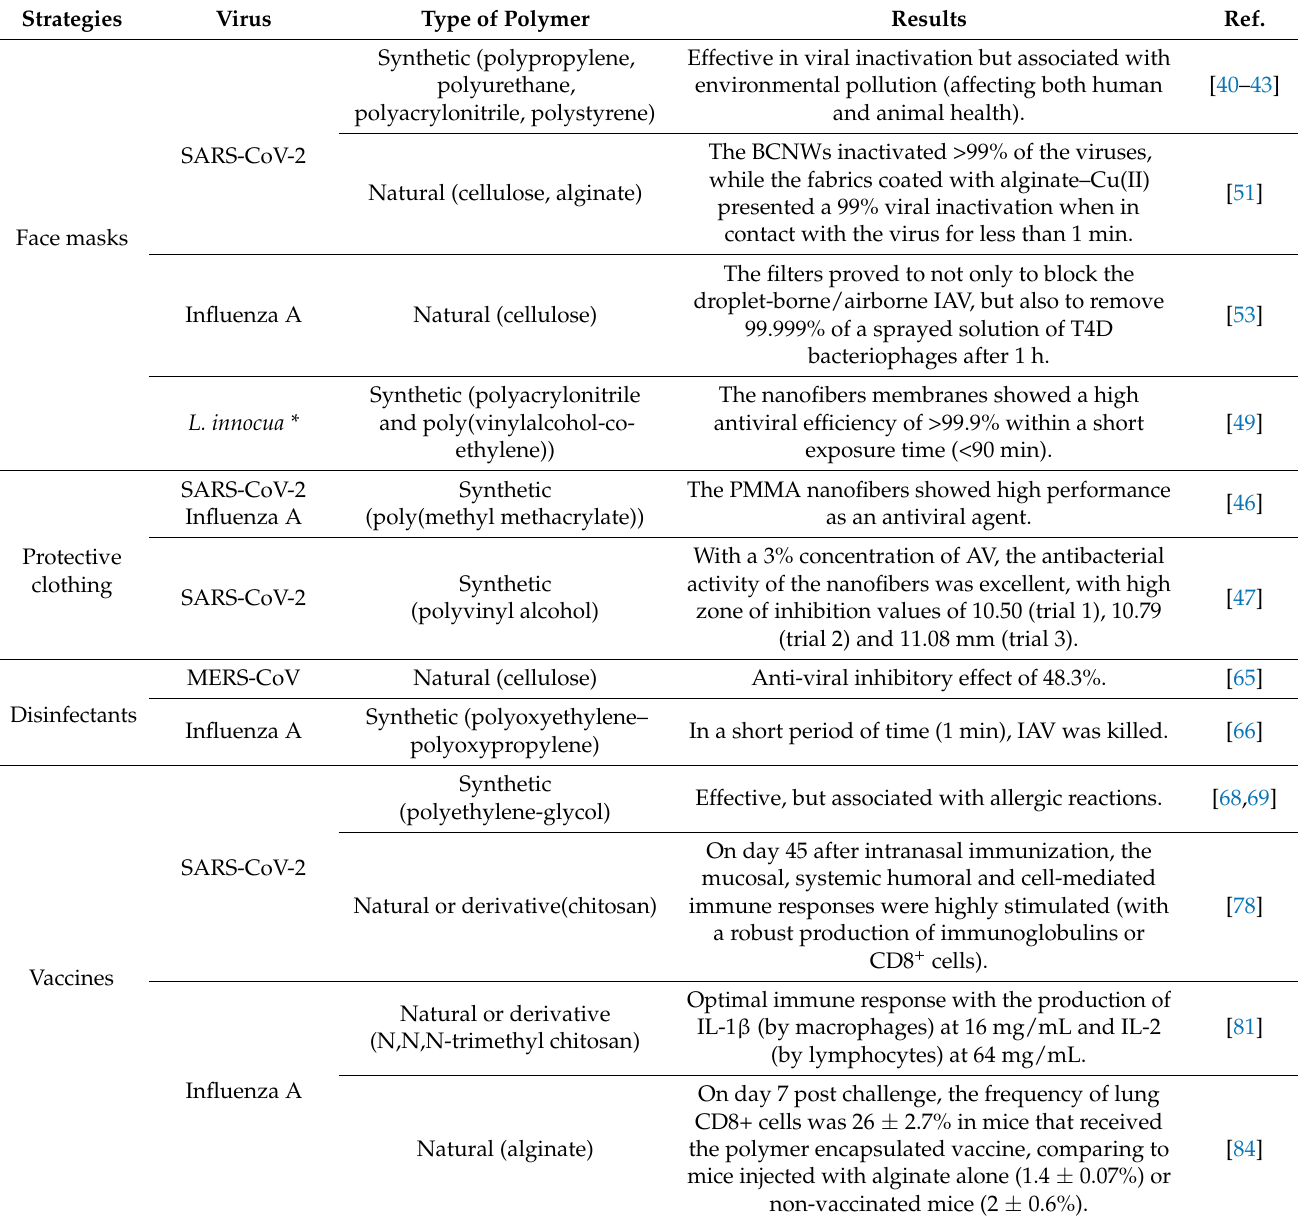
Table 1. Polymer-based strategies applied in the prevention of SARS-CoV-2 and influenza A